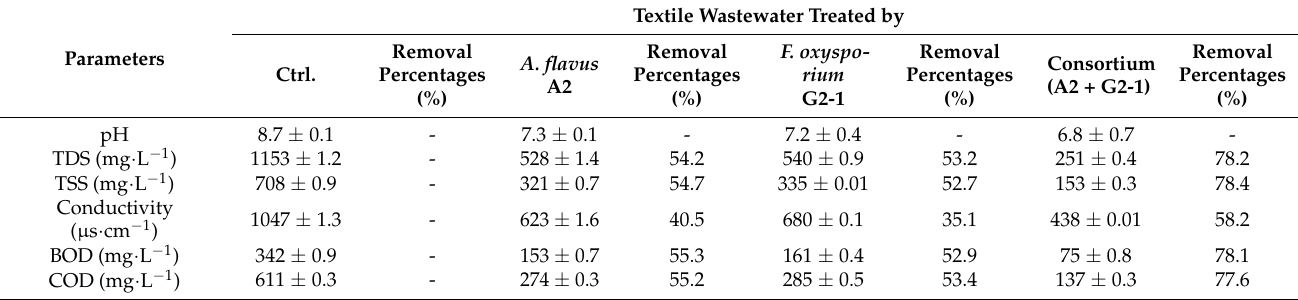
Table 2. Physicochemical characteristics of a textile effluent before and after treatment using the individual and consortium fungal strains. Parameters